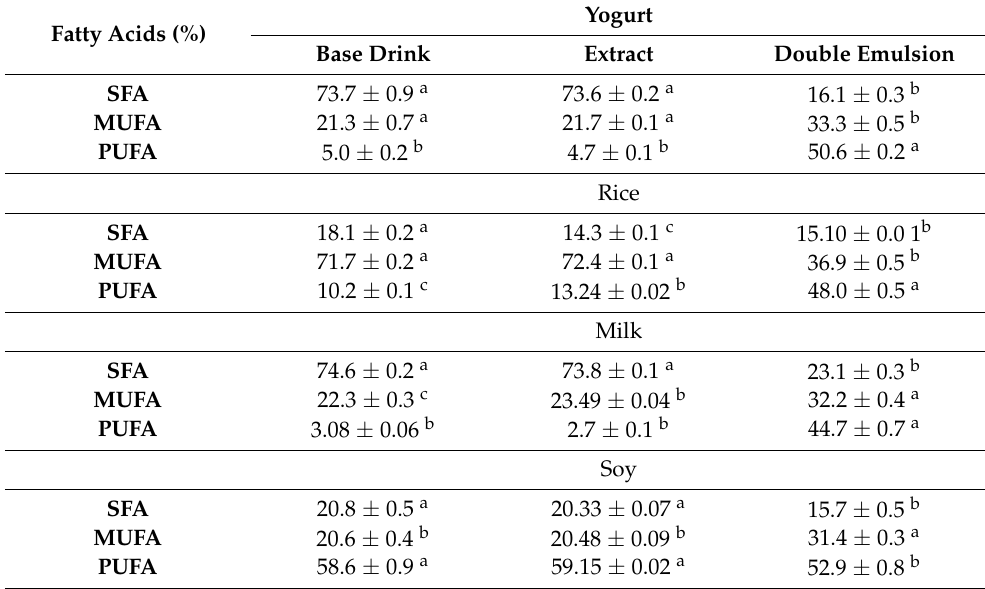
Table 5. Fatty acids composition, expressed as SFA, MUFA, and PUFA, of the studied base food matrices (control) and respective colored systems (with extract or double emulsion) (mean ± SD, n = 9). Yogurt Fatty Acids (%) Base Drink Extract Double Emulsion SFA 73.7 ± 0.9 a